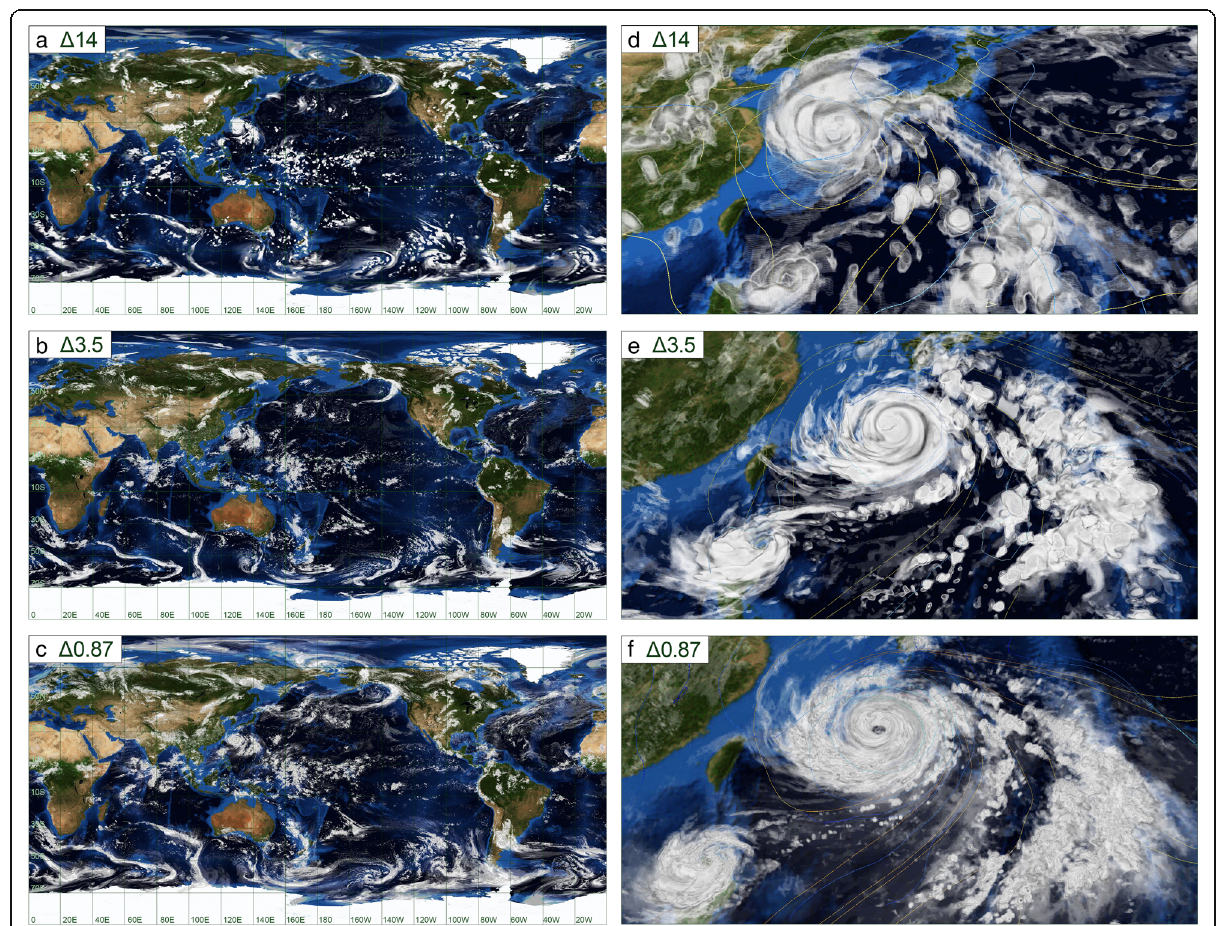
Fig. 3 Resolution dependencies of simulated cloud distribution. Global view of simulations with a 14 km, b 3.5 km, and c 0.87 km grid spacing. d – f Focus over the western North Pacific region of ( a – c ), respectively. After Fig. 3 of Kajikawa et al.